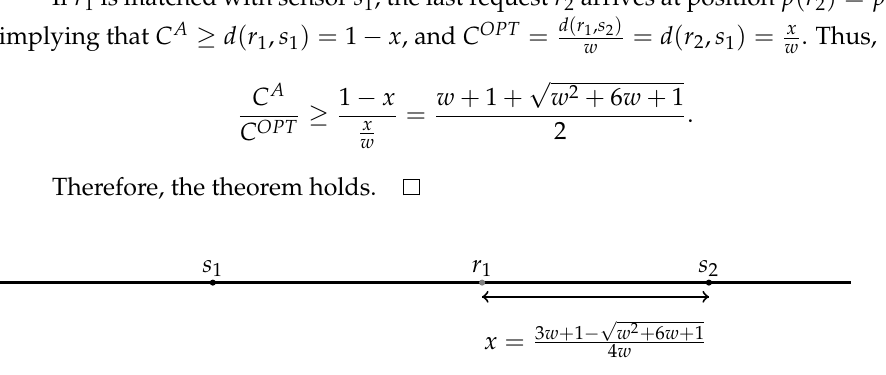
Figure 3. The locations of sensors and